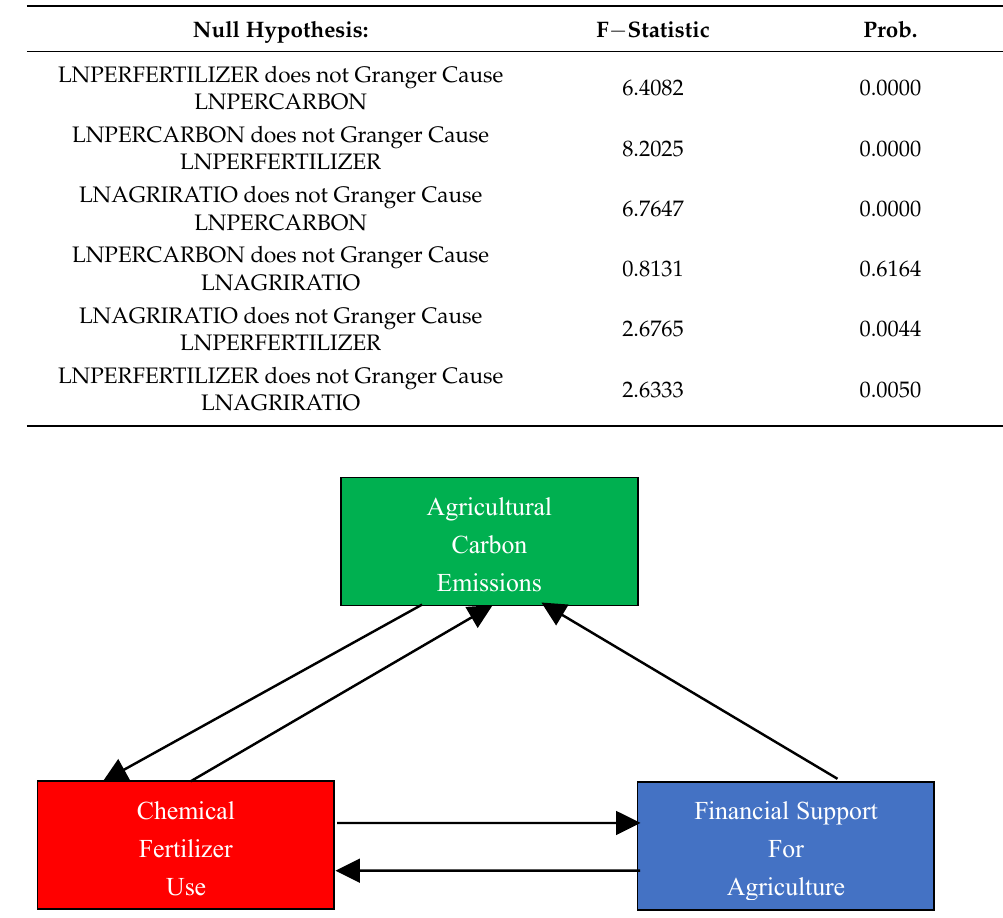
Figure 2. The Granger causalities between variables. A → B represents A Granger cause B. For example, financial support for agriculture → agricultural carbon emissions means that there is a one − way causality between chemical fertilizer use and agricultural carbon emissions.